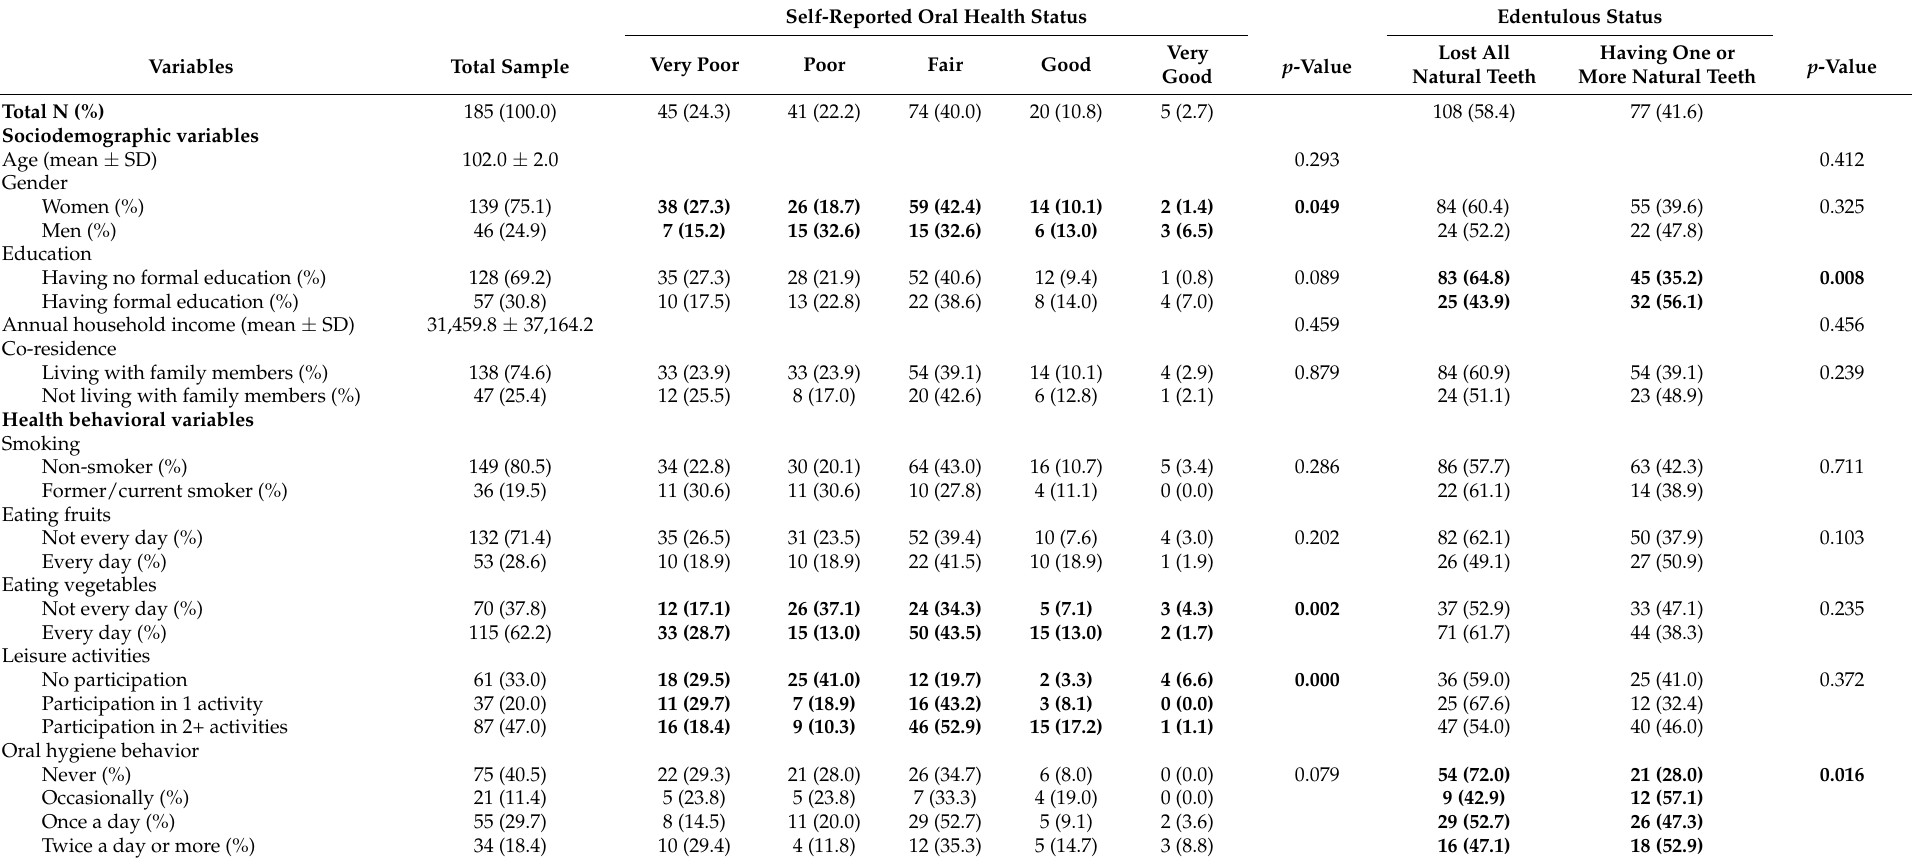
Table 1. Sample by study